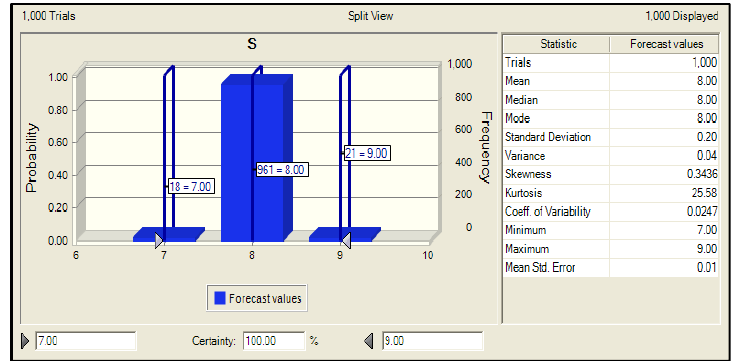
Figure 11. Case 1: Discrete nonuniform distribution of D in CB software.